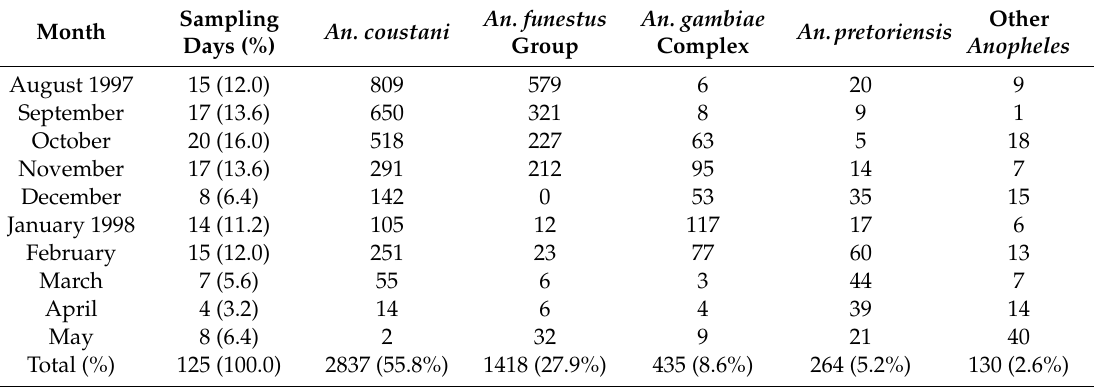
Table 8. Monthly human landing captures o ff eight humans sitting 18:00 to 22:00, usually four nights per month at seven sites in Mpumalanga Province, August 1997 to May 1998